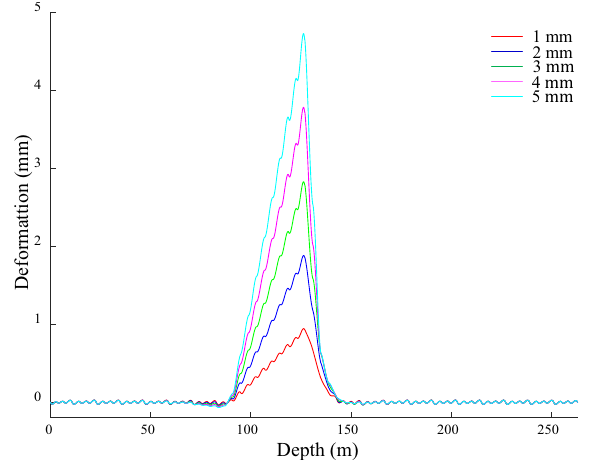
Figure 15. GRD in x -direction under